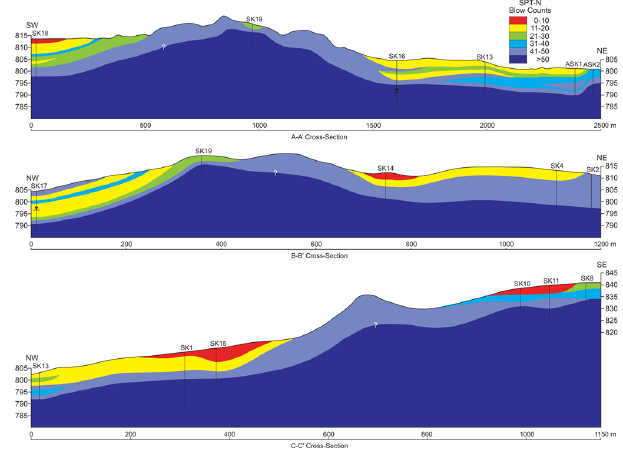
Fig. 7. Layering properties of the soils.